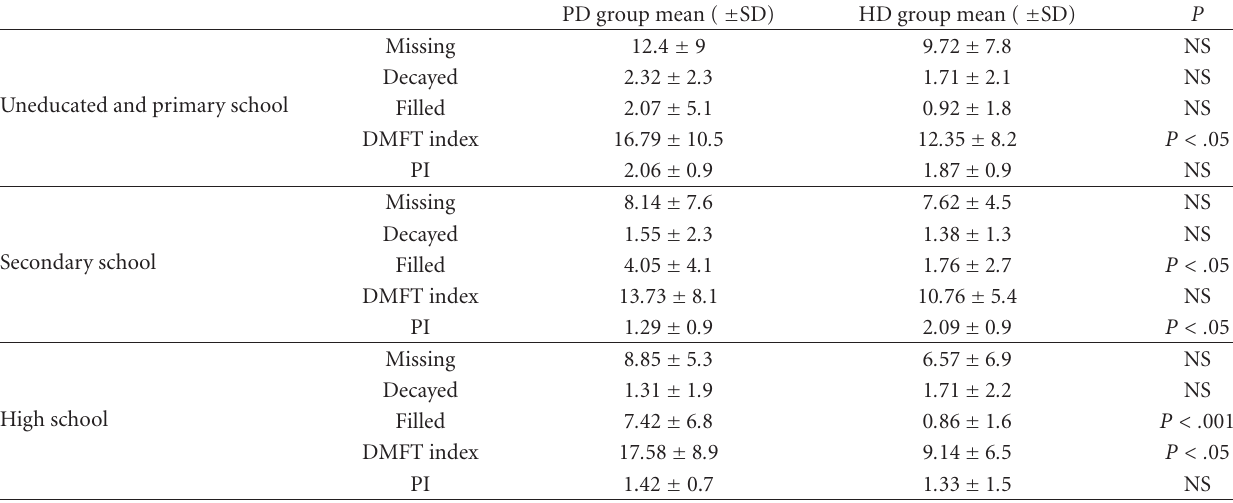
Table 5: Mean ( ± SD) values and statistical comparisons for missing, decayed, and filled teeth, DMFT index, and PI in the PD and HD groups based upon their educational